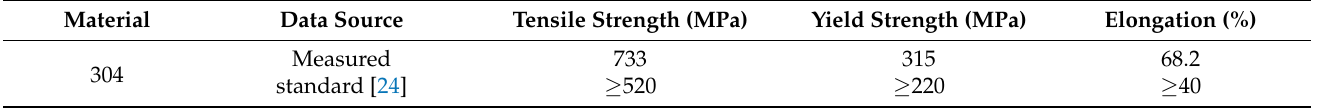
Table 2. Tensile properties of the base